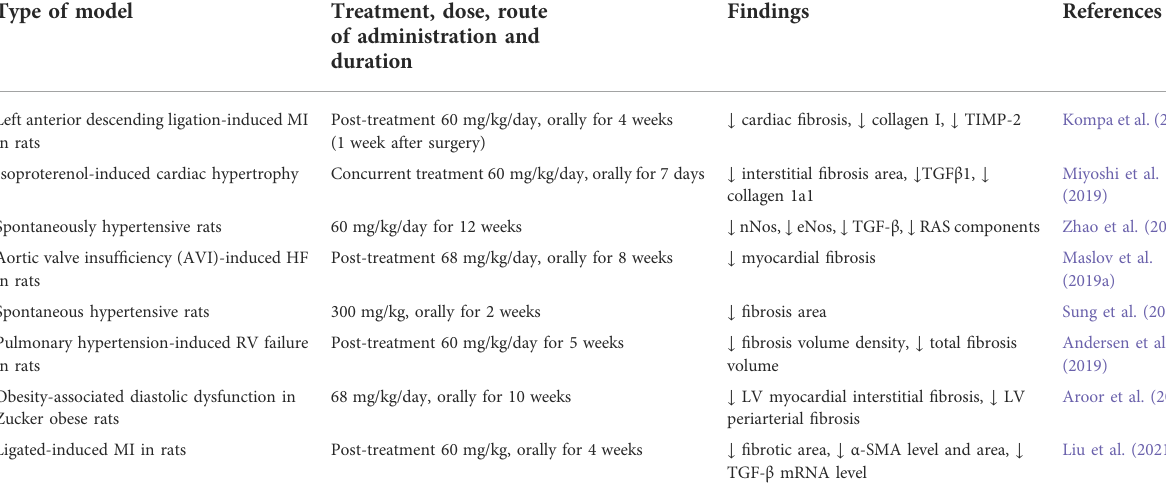
TABLE 5 The effects of sacubitril/valsartan on myocardial fi brosis in animal